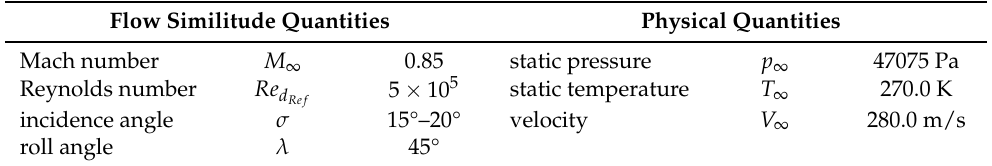
Table 1. LK6E2 test case flow conditions.